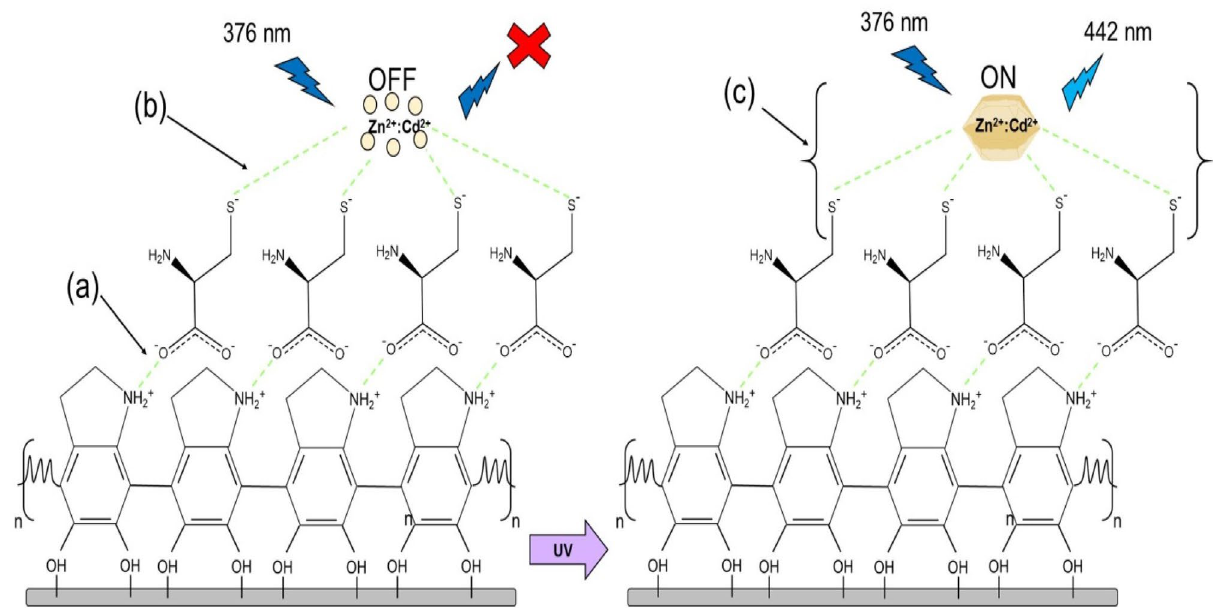
Figure 7. ( a ) Schematic illustration of the possible situation in polydopamine and l-cysteine interaction, ( b ) thiolate anion interaction with the precursors, and ( c ) formation of ZnCd/S QDs after UV irradiation.